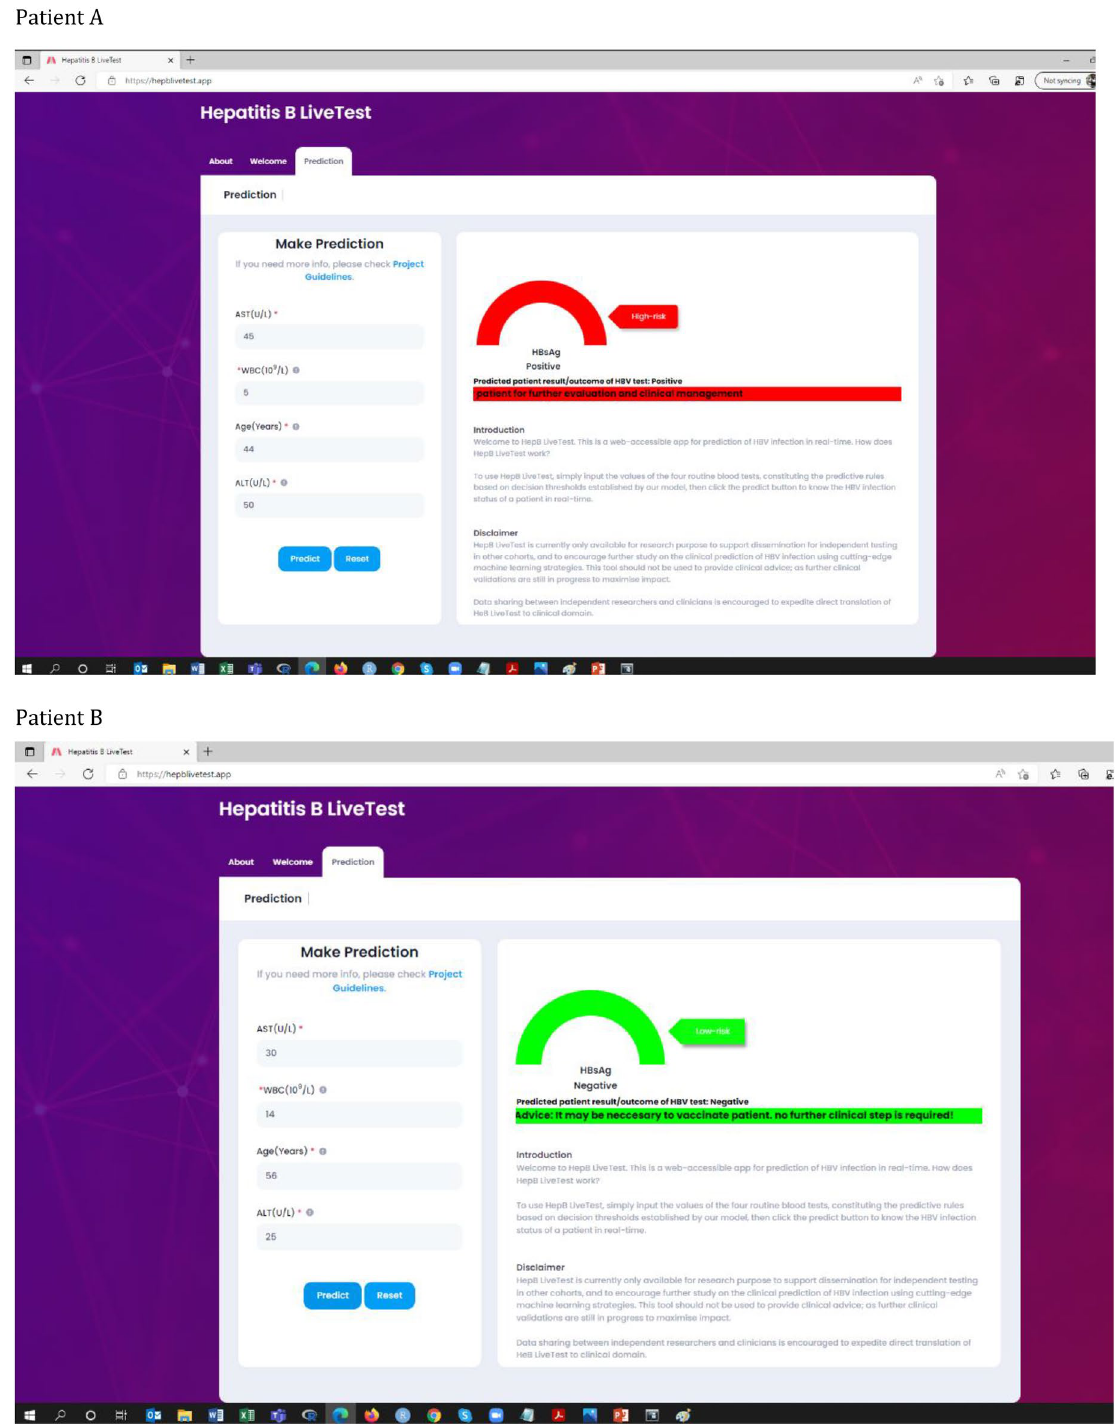
Figure 6. Web application of the model (https:// www. hepbl ivete st. app/) and the result of two hypothetical patients ( A and B